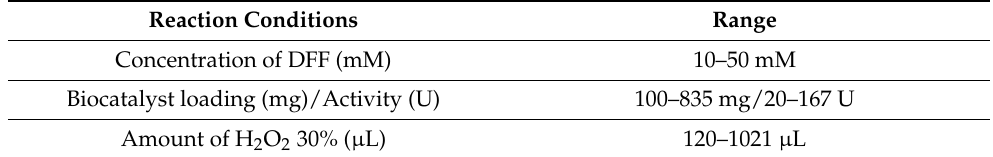
Table 1. Reaction conditions are to be